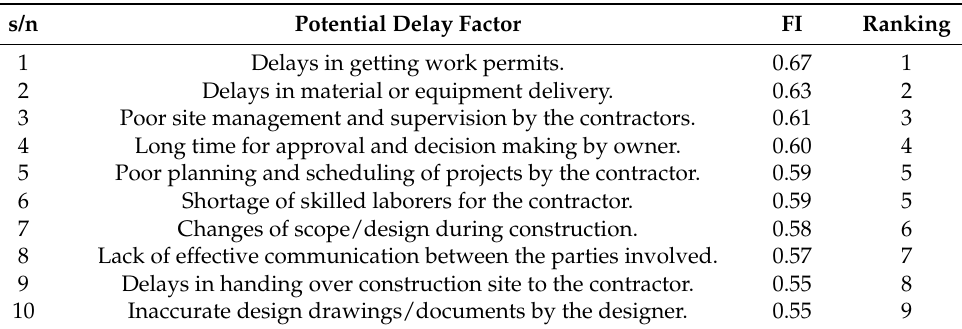
Table 5. The Frequency Importance Index